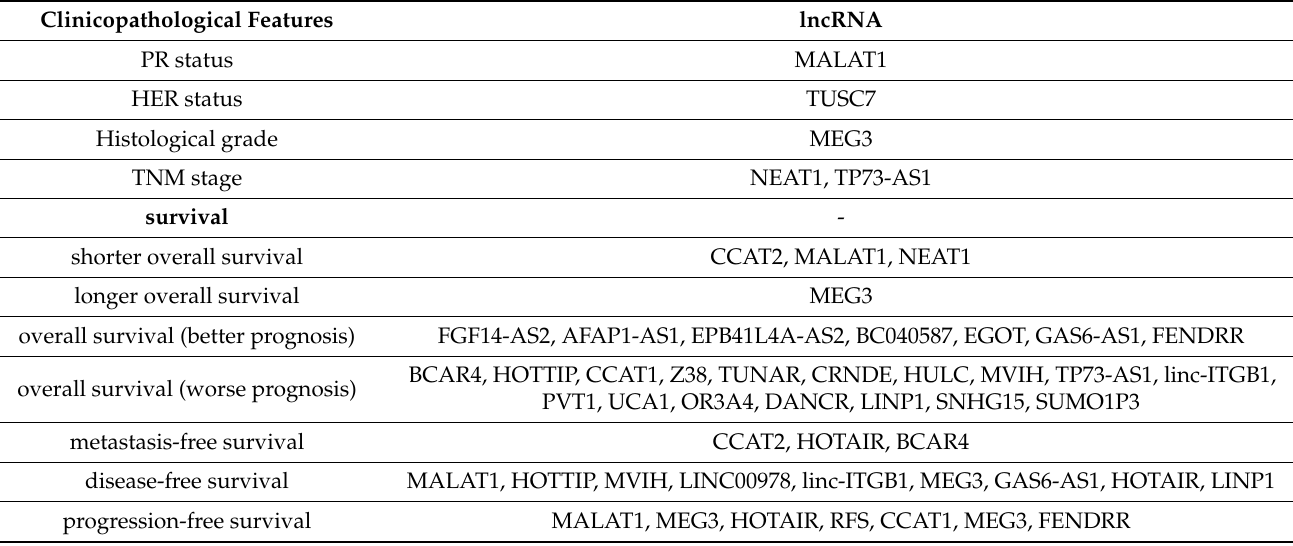
Table 2. Summary of lncRNAs related to clinicopathological features and survival of breast carcinoma. Clinicopathological